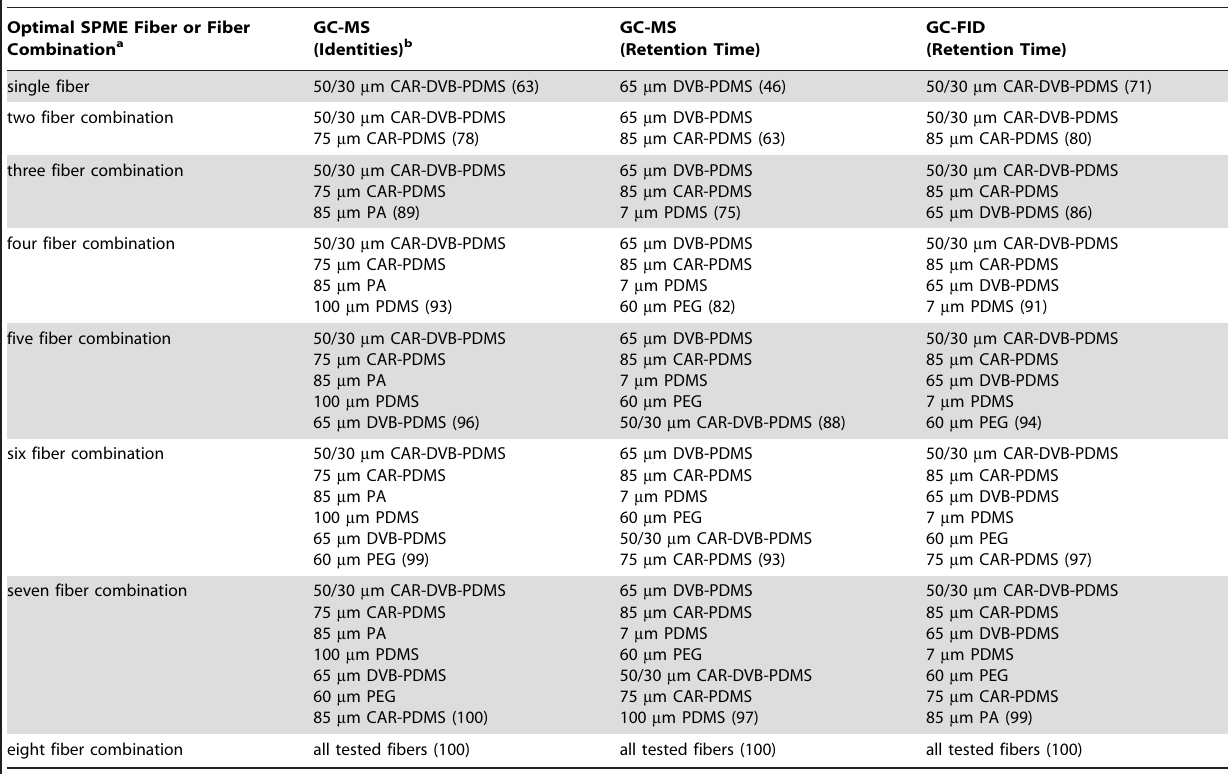
Table 3. Top fiber